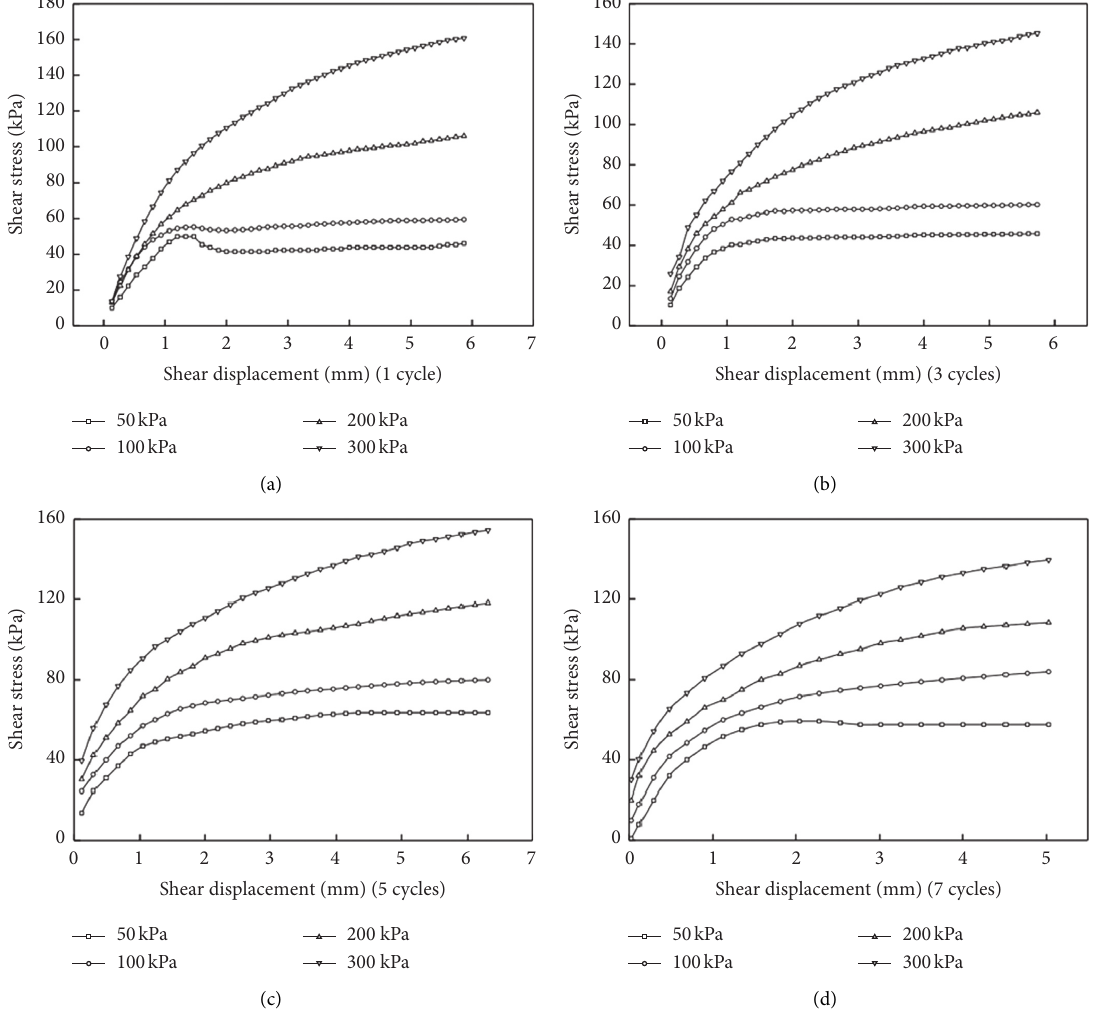
Figure 8: Direct shear test curve of red clay under different dry and wet cycles ( ρ